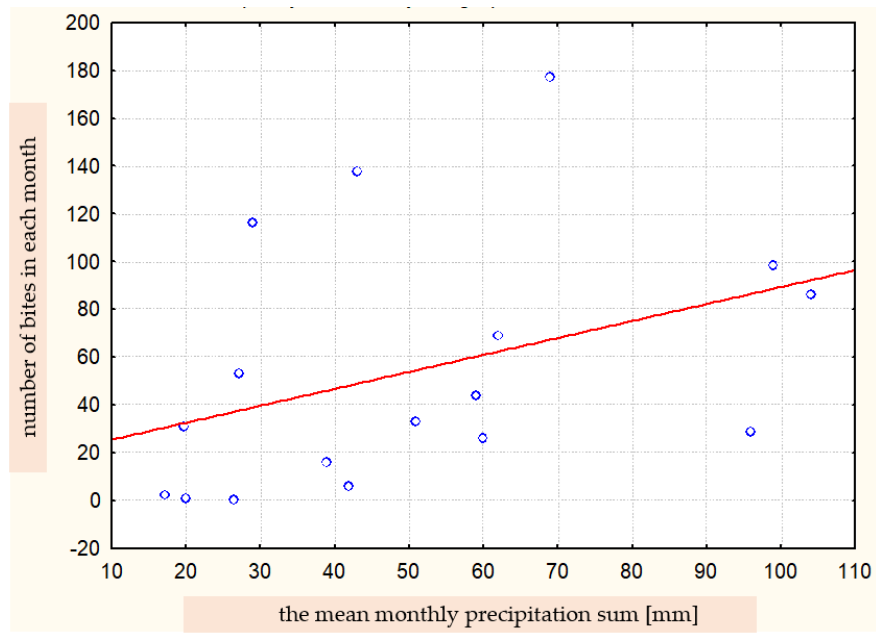
Figure 8. Correlation between the number of bites in a given month and the mean monthly precipita-